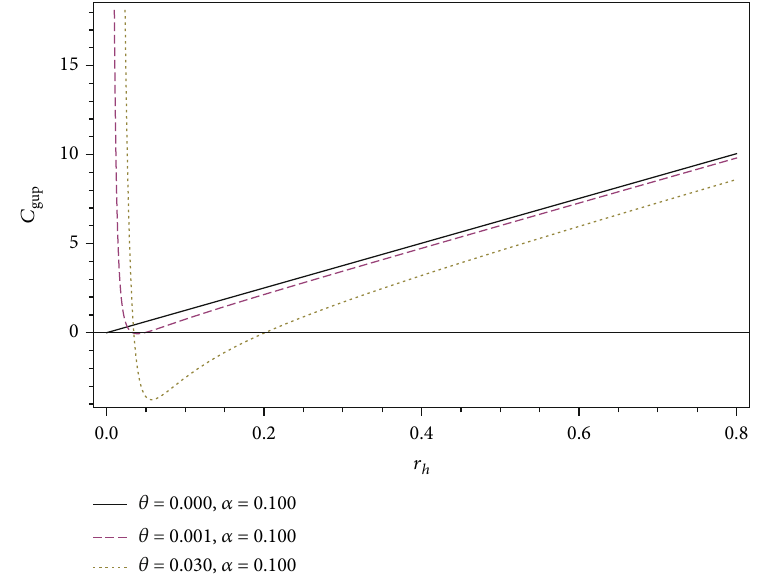
Figure 1: Speci fi c heat capacity (equation (63)). For θ = α = 0 , we have the result for the speci fi c heat of the commutative BTZ black hole. We also show the result when θ ≠ 0 and α ≠ 0